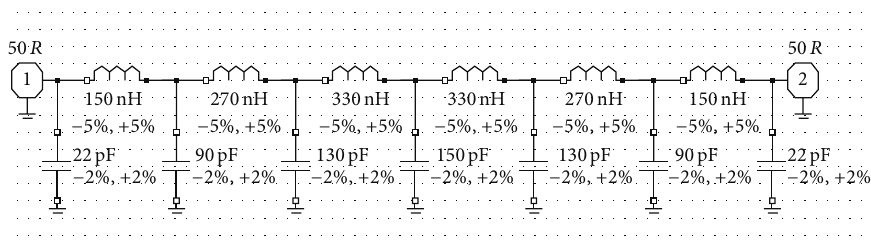
Figure 6: Schematic diagram of the low-pass filter.